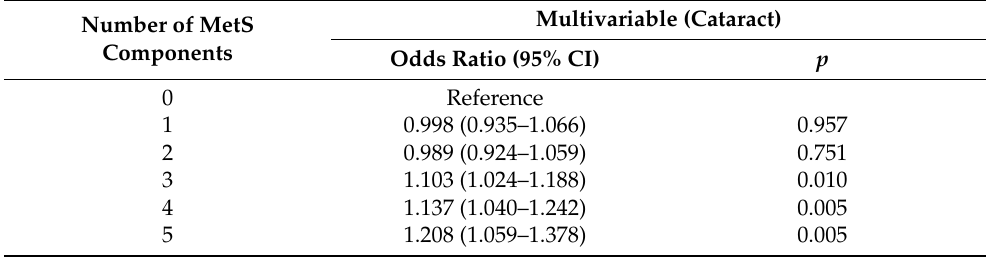
Table 3. Association of MetS numbers and cataract using multivariable logistic regression analysis.